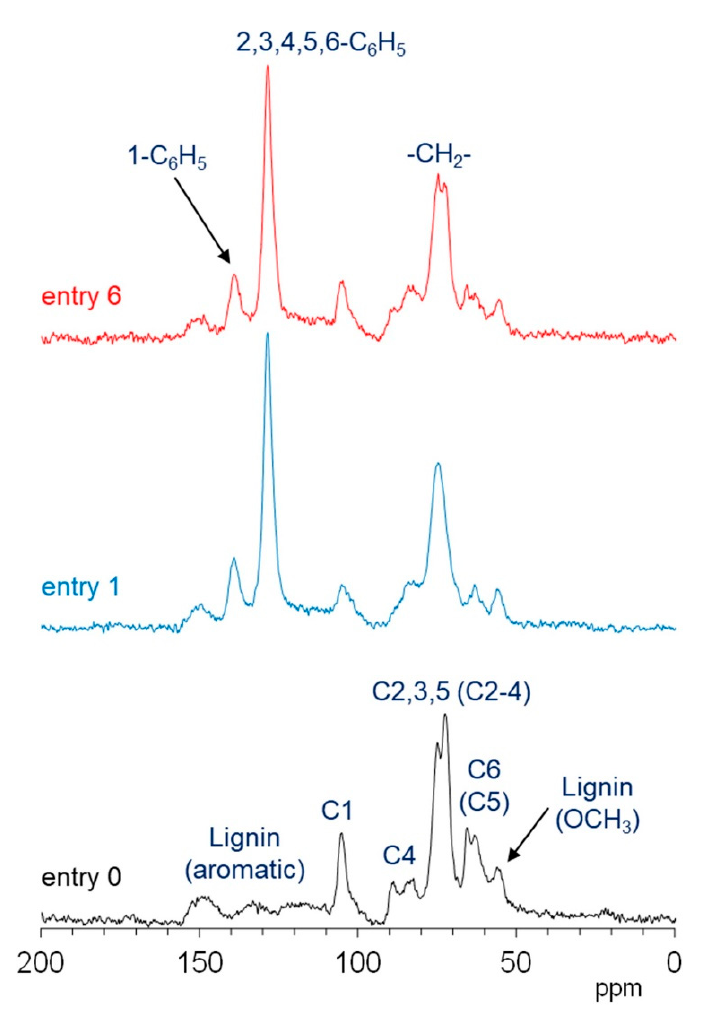
Figure 7. 13 C CP-MAS NMR spectra of degreased wood powder (entry 0, black) and benzylated wood powders (entry 1, blue; and entry 6, red).